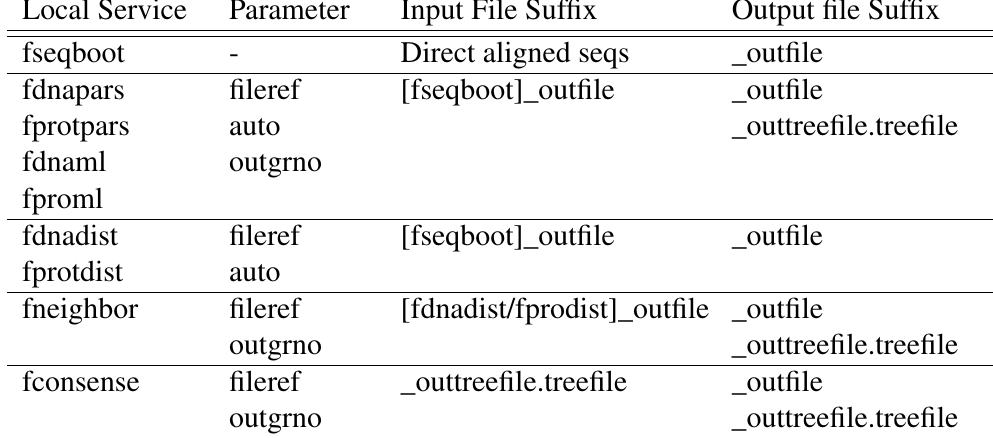
Table 3: The modified local services and their